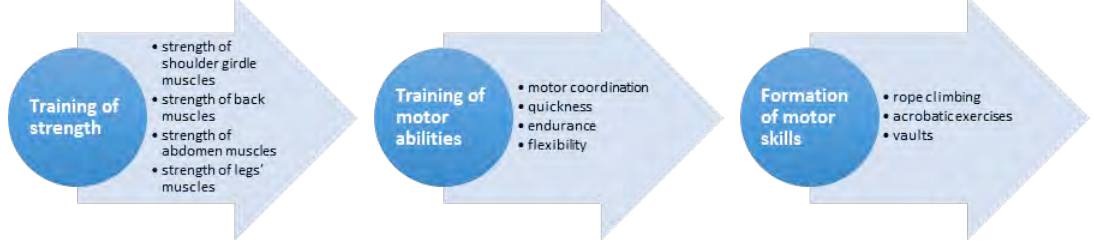
Fig. 2. Diagram of motor abilities’ development and process of motor skills’ formation in 11-13 yrs girls Table 5. Point-by-point statistics